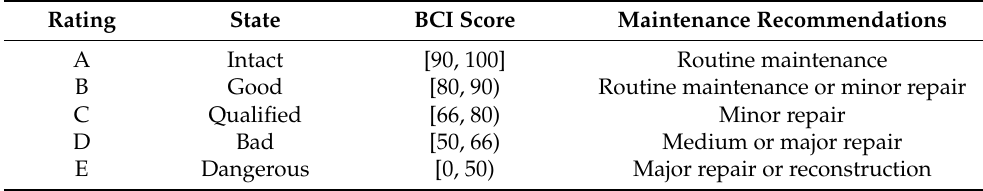
Table 2. Definition of bridge condition ratings in China (CJJ